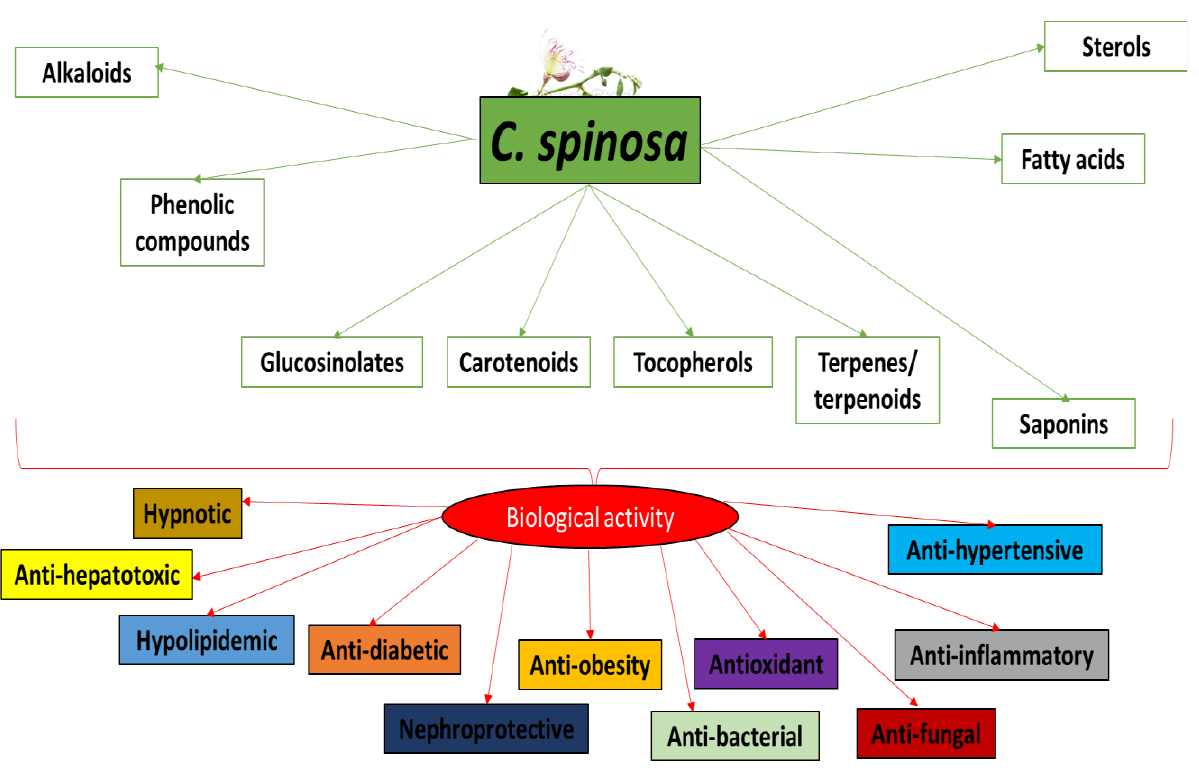
Figure 1. The major chemical compounds identified in C. spinosa and their biological properties. All Capparis species are sources of sulfur-rich metabolites called glucosinolates, which are derived from amino acids. They can be divided into three groups according to their amino acid precursor: indolic, benzonic, and aliphatic. In capers, the most widely distributed is methyl glucosinolate or glucocaprin, constituting 2.05 ± 0.25 mg/g